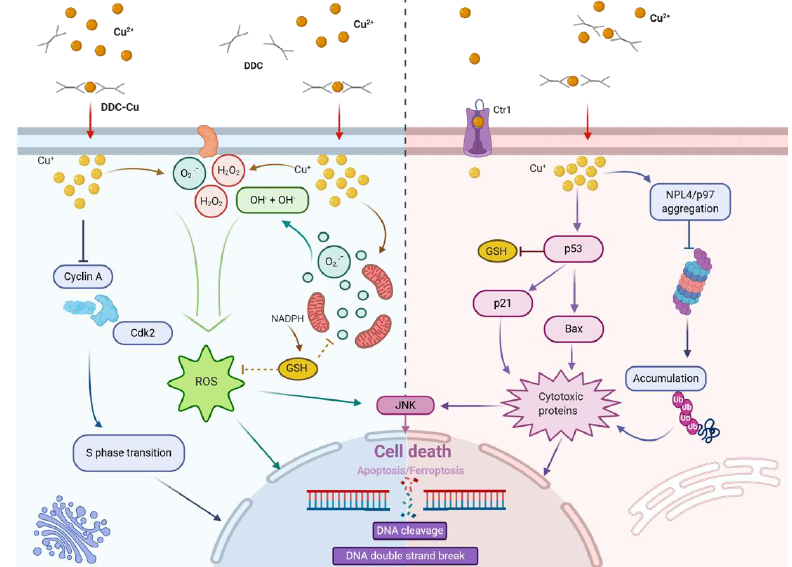
Figure 2. Mode of action of disulfiram-derived diethyldihtiocarbamate (DDC) on cancer cells. Cellular uptake of DDC-Cu 2+ causes an increase in the free copper pool (Cu + ) which provokes massive induction of reactive oxygen species (ROS) that have a vast range of effects, including the induction of DNA damage ( left ). At the same time, the copper accumulation leads to the activation of p53 signalling, dysfunction of proteasomal removal of poly-ubiquitinylated proteins, activation of stress-activated protein kinases like JNK and the induction of death pathways ( right ).